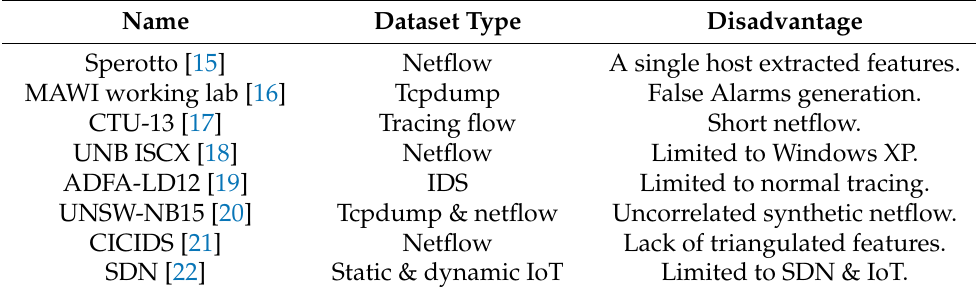
Table 1. The most recent datasets for the NIDP in the